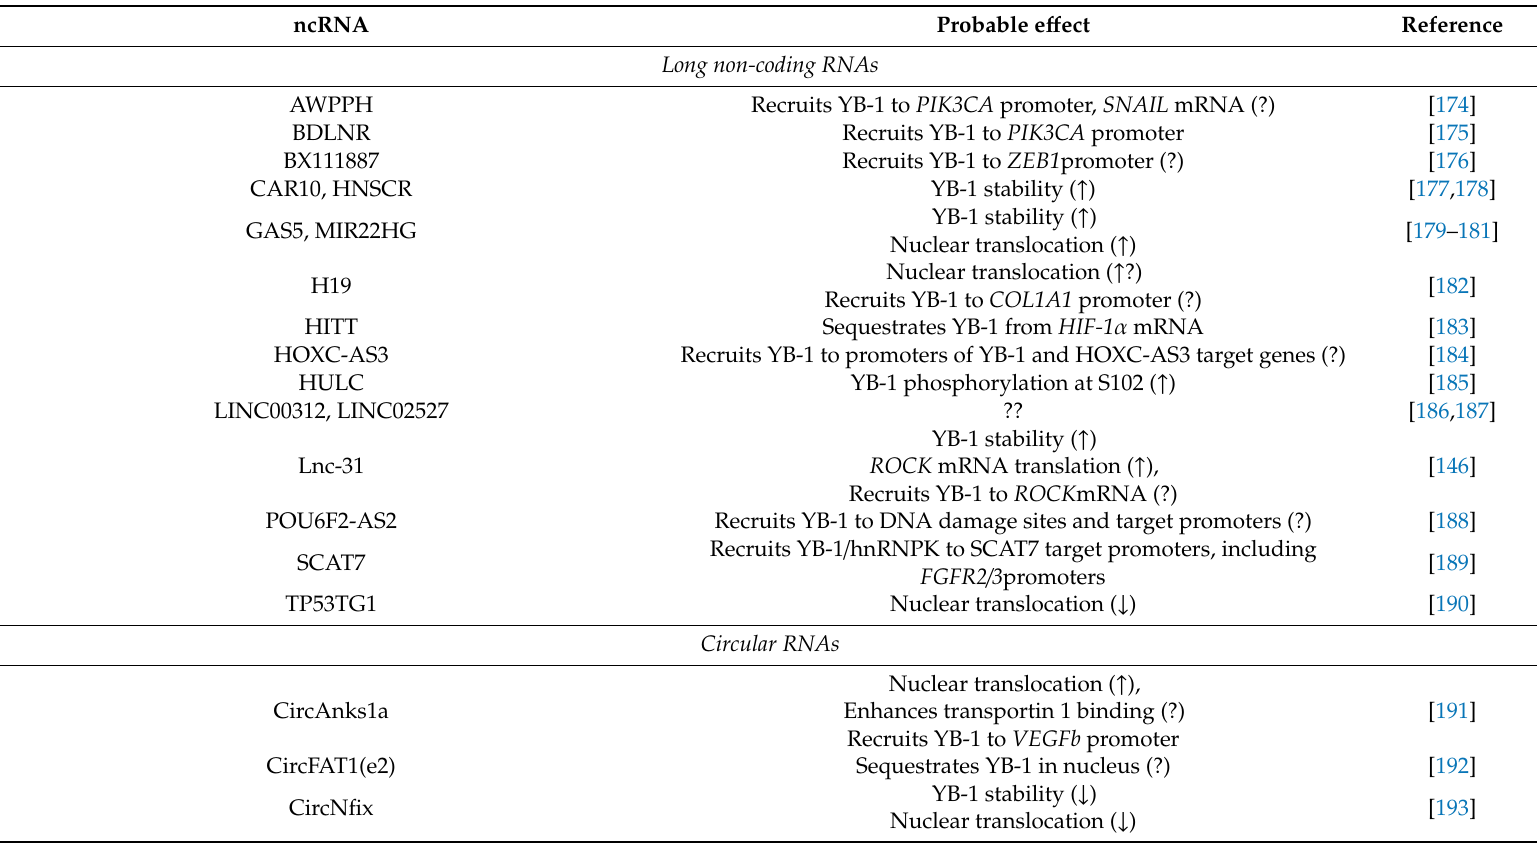
Table 2. YB-1-interacting non-coding RNAs and their probable e ff ects on YB-1 functions. Notation: ↑ —up-regulation; ↓ —down-regulation; ?—indirect evidence; ??—unknown